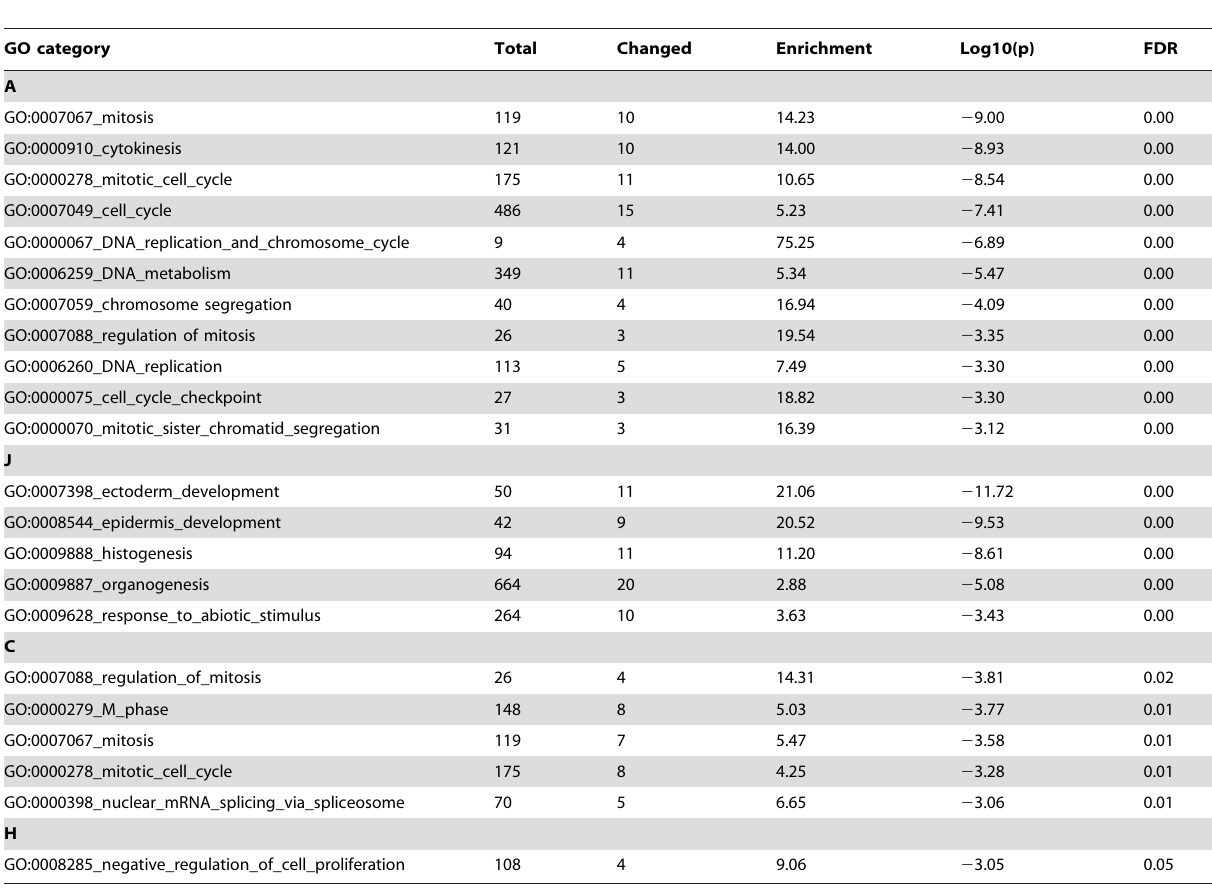
Table 1. GeneOntology analysis of gene expression signatures during immortalization and/or transformation.